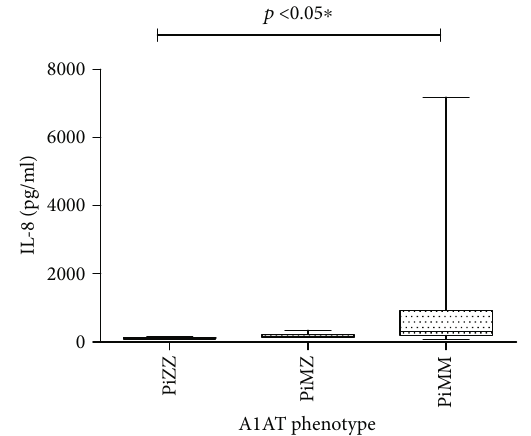
Figure 5: Comparison of IL-8 levels in COPD patients with PiZZ, PiMZ, and PiMM phenotypes of A1AT.